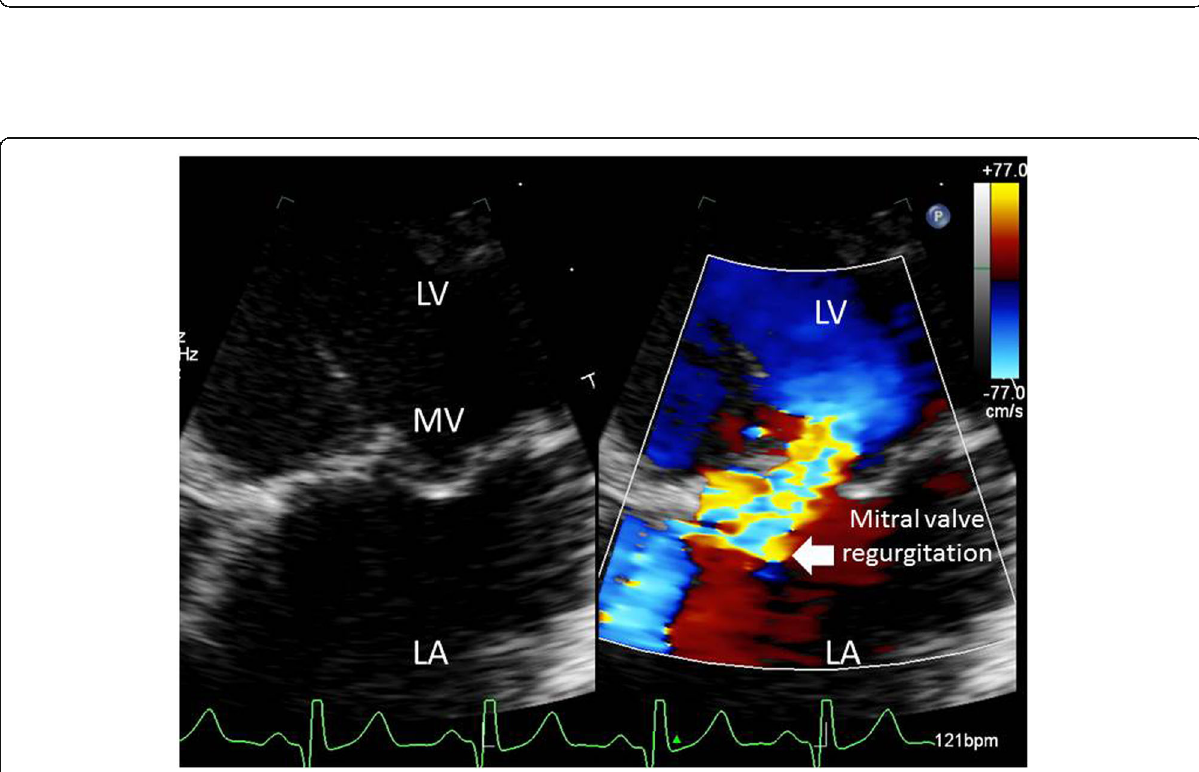
Fig. 3 Apical 4 chamber view, focused on mitral valve. Notice the large mitral regurgitation jet on color Doppler. LV: left ventricle; LA: left atrium; MV: mitral valve